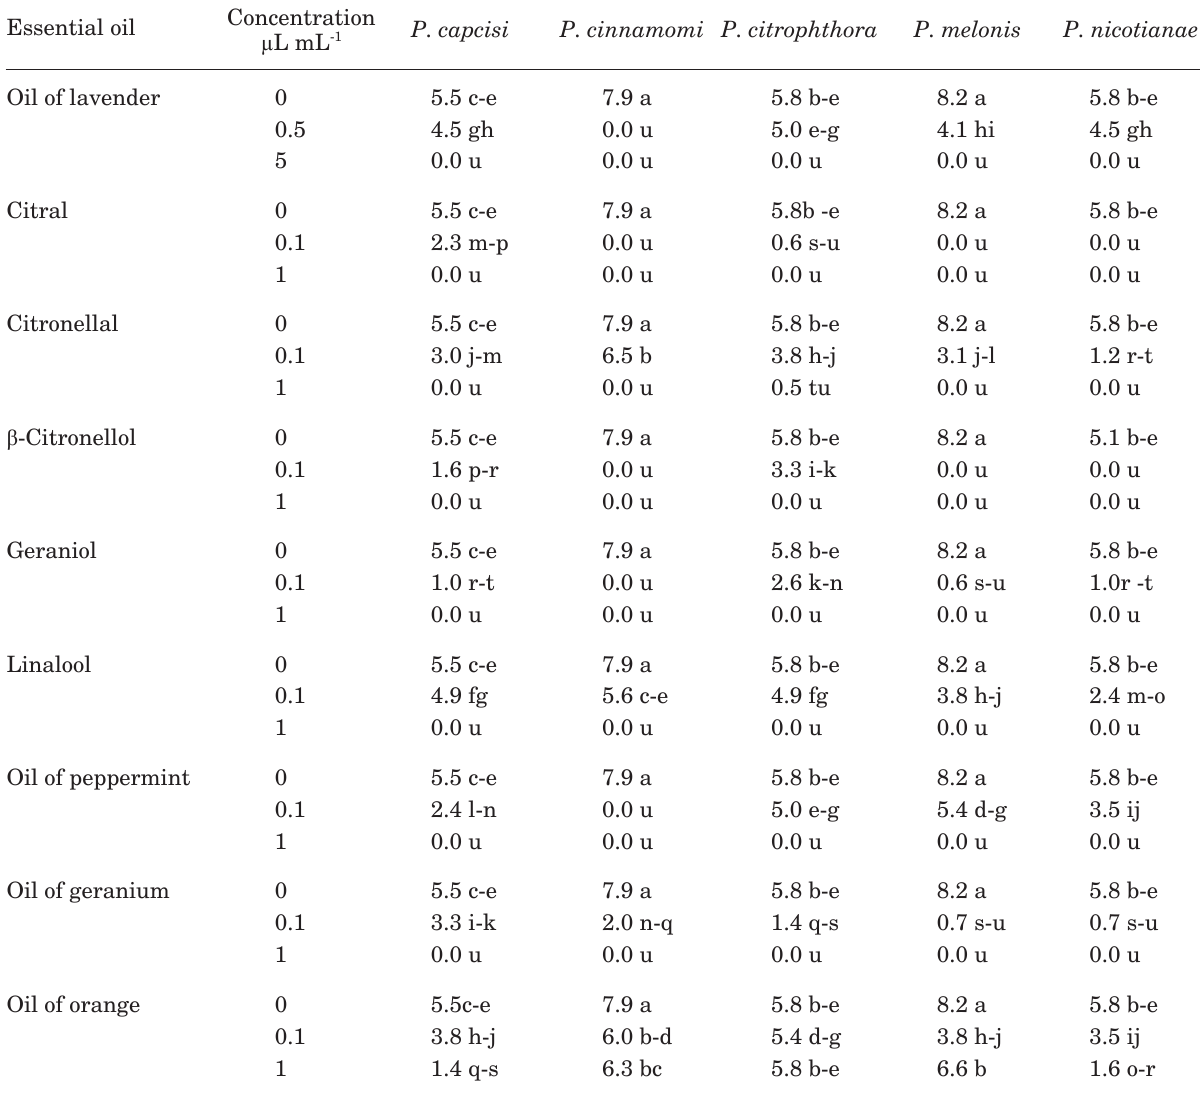
Table 2. Mean colony growth rate (mm day -1 )( contact effects) for different Phytophthora spp. grown on agar plates amended with different essential oils a